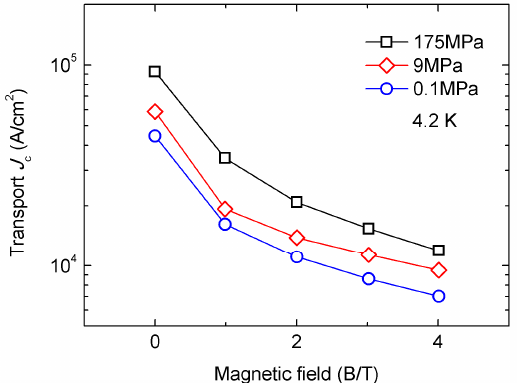
Figure 17. Transport J c of the CaKFe 4 As 4 samples heat-treated at 175 MPa, 9 MPa, and 0.1 MPa. Some data are based on [62].